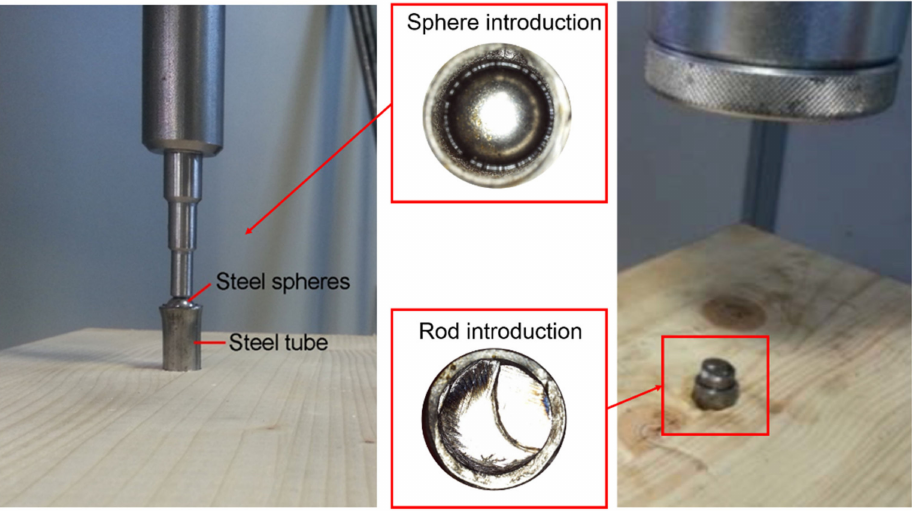
Figure 6. Expansion of the steel tube using steel